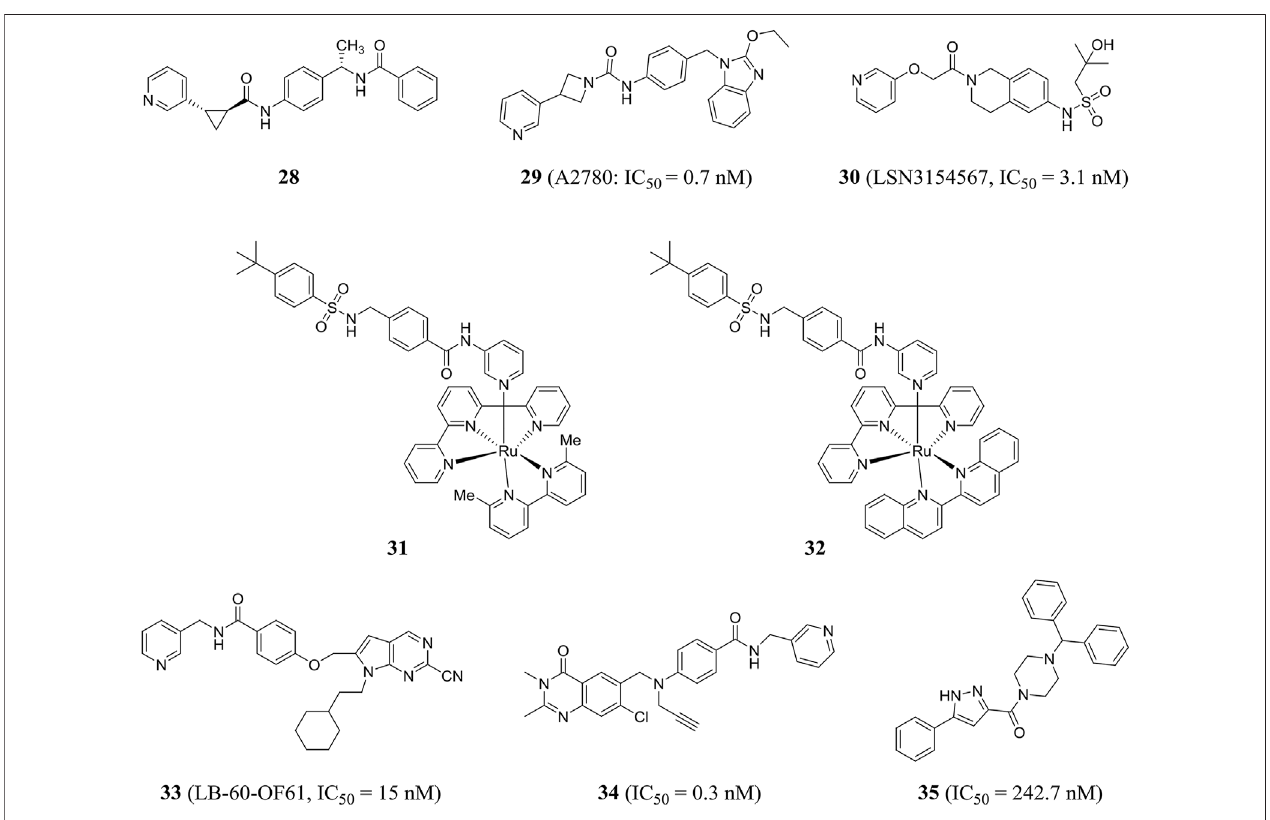
FIGURE 8 | Chemical structures and kinase activities of NAMPT inhibitors 28 – 35 .